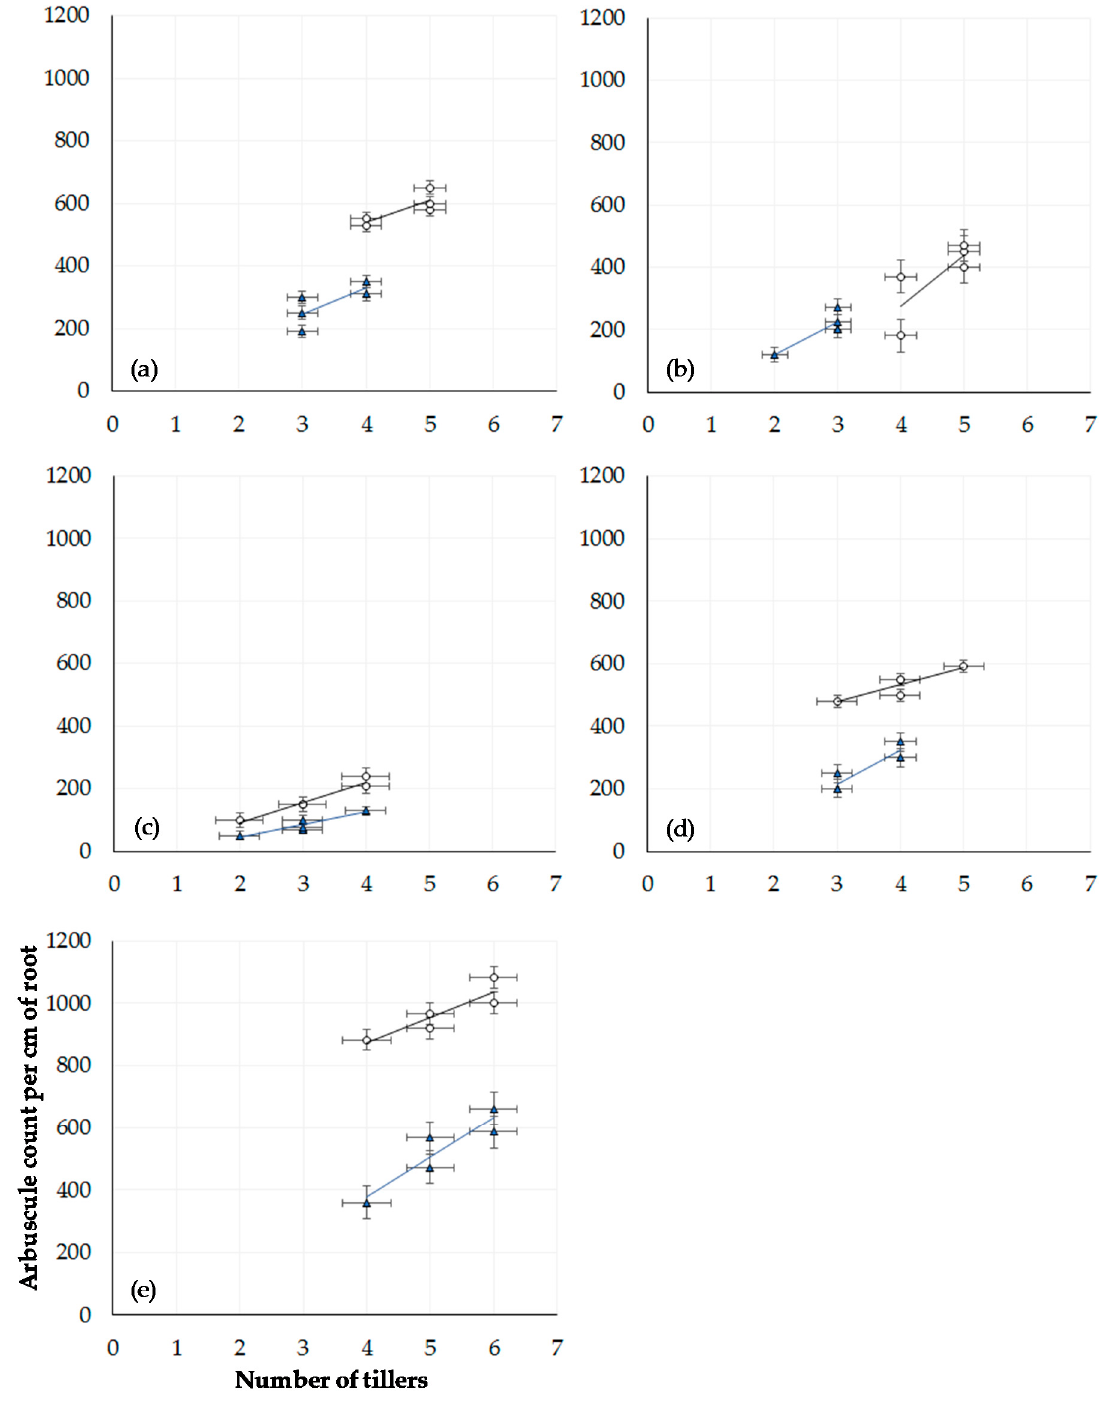
Figure 6. Relationship between tiller number and arbuscule count (n = 300) at week 15 in 60 winter wheat plants grown in field extracted soil managed under either conventional (blue triangle) or zero tillage (white circle): ( a ) control with zero inoculant, ( b ) AM fungi, ( c ) B. subtilis , ( d ) B. pumilis , and ( e ) B. amyloliquefaciens . Error bars = one SEM.